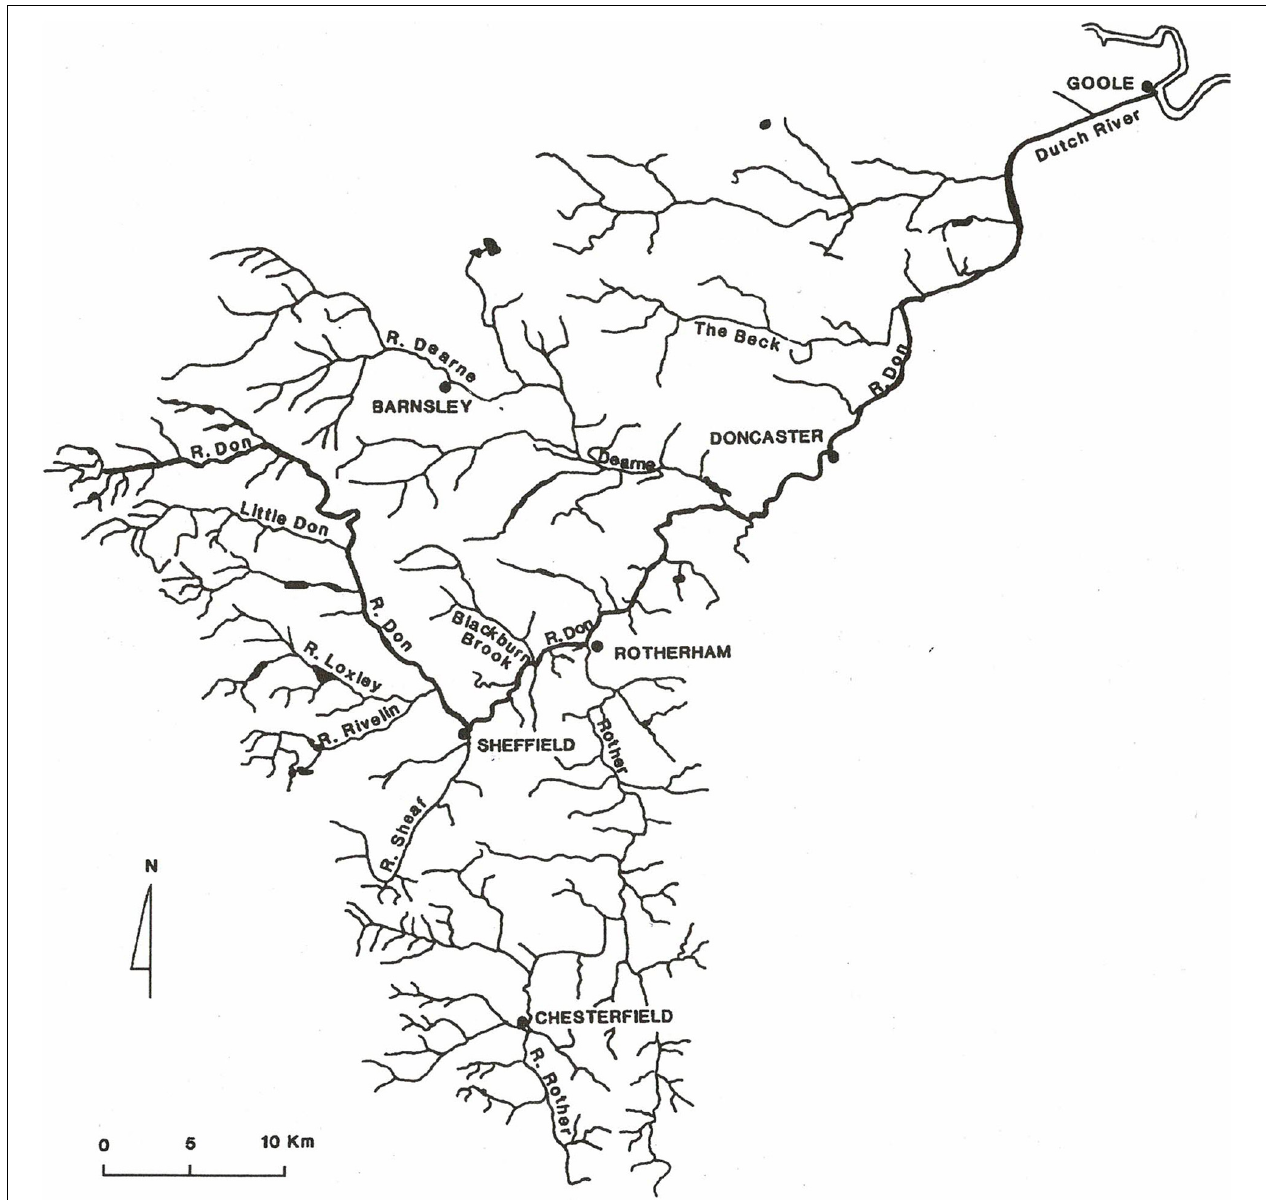
FIGURE 2 | River Don